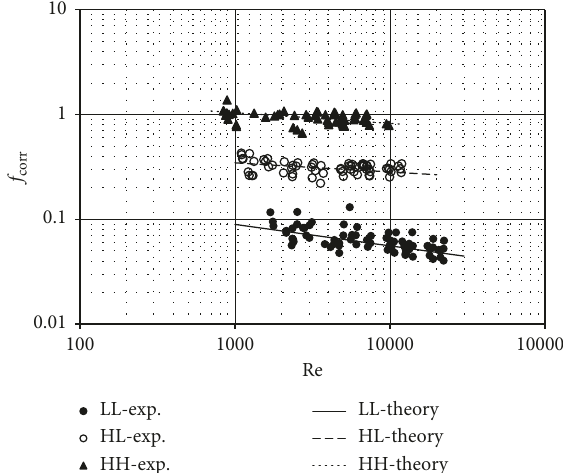
Figure 11: Fanning friction factor f HL corrugated field.